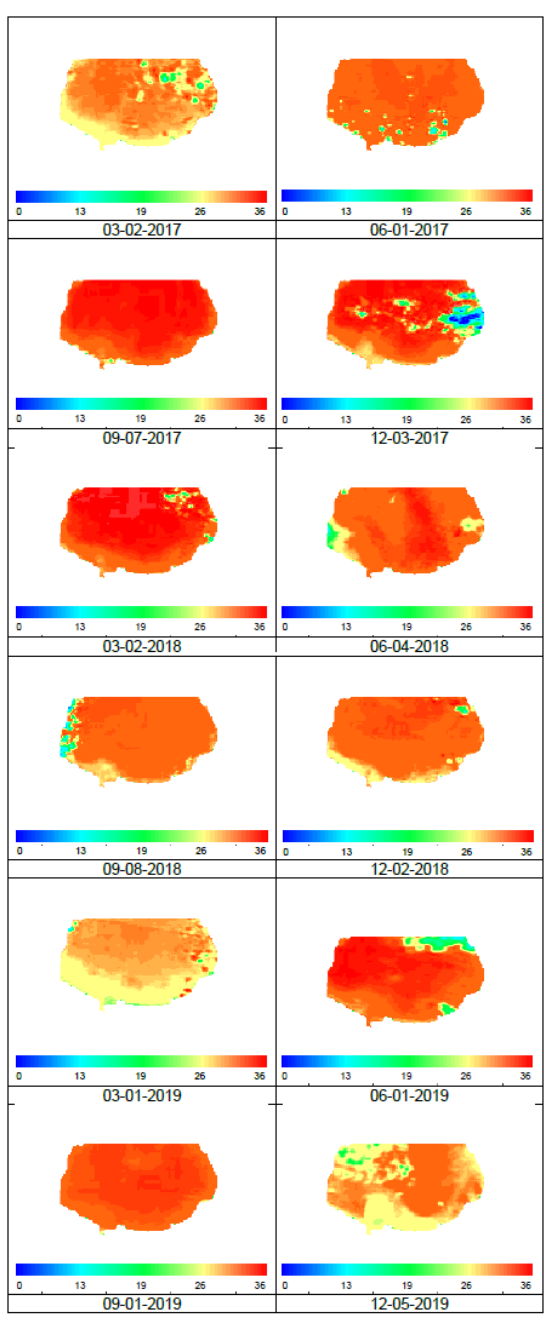
Figure 11 . Quarterly Spatio-temporal Map of SMB –